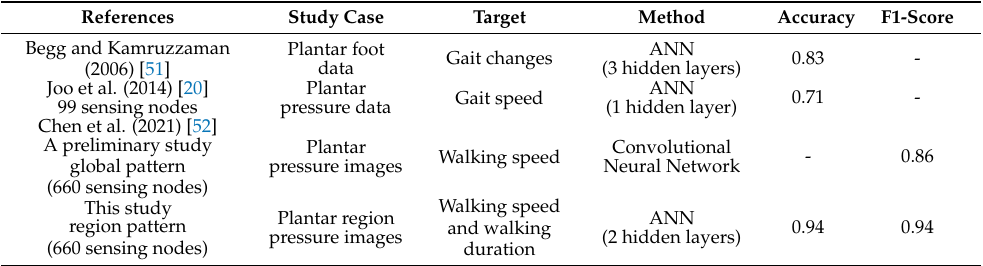
Table 3. Comparison of the performance of the classification model based on plantar pressure images with relevant